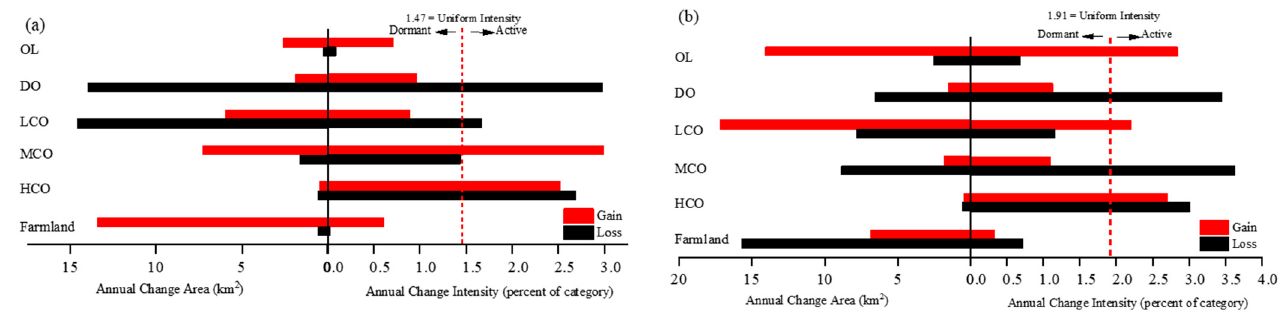
Figure 3. Category level intensity analysis for ( a ) 1984–2007; ( b ) 2008–2018.